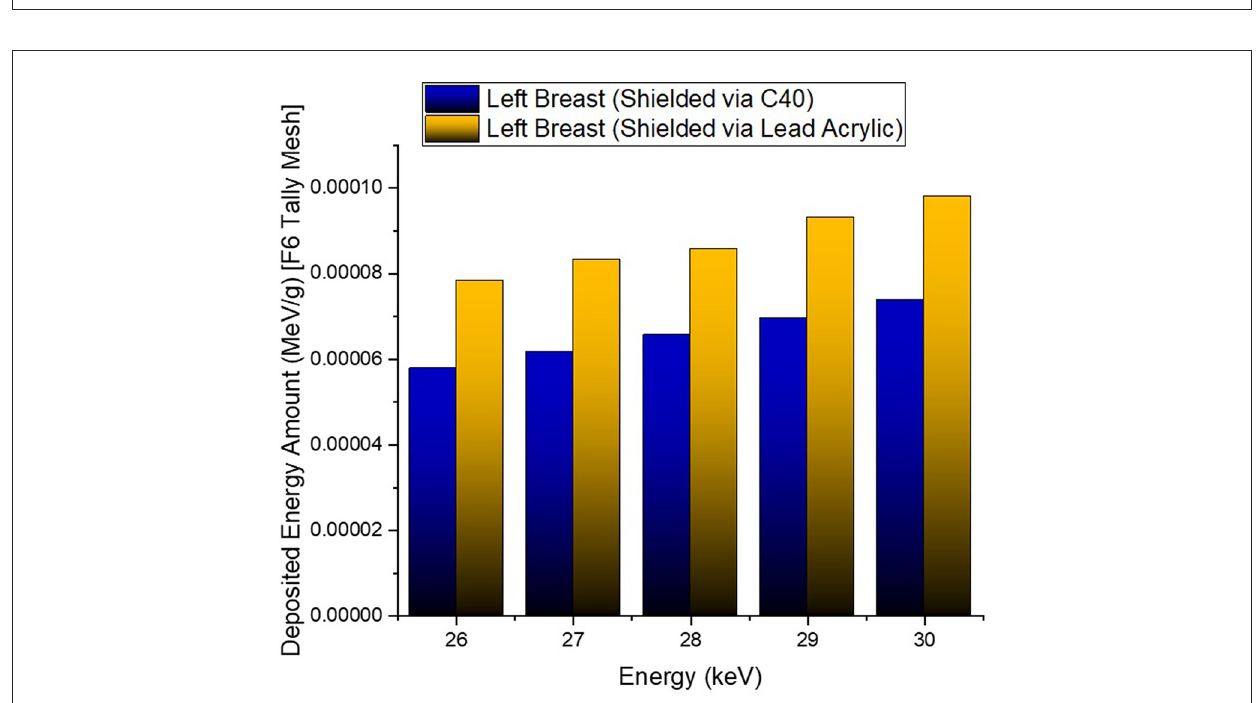
FIGURE12 Variation of total deposited energy amount in the left breast.